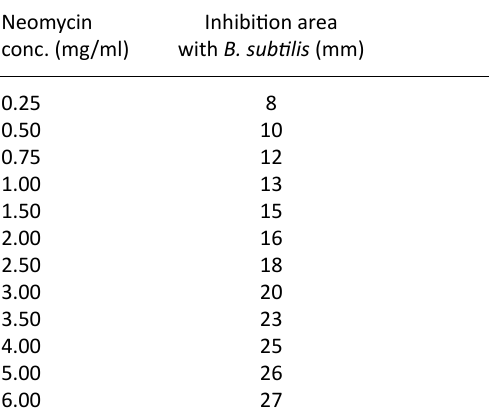
Table 1. Diameters of inhibition area with several concentrations of neomycin were used Neomycin Inhibition